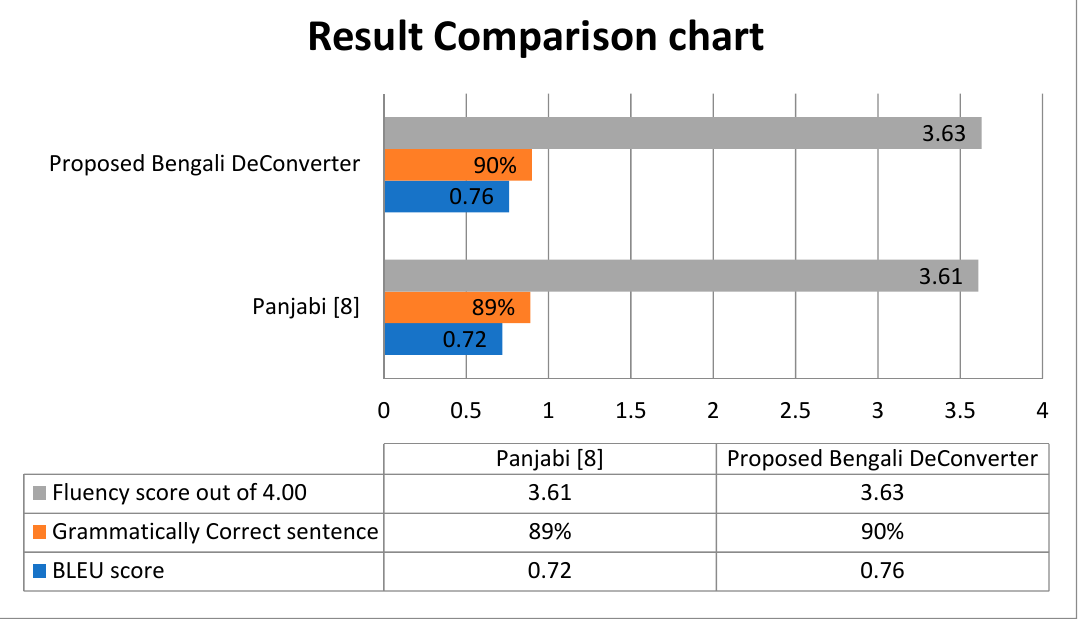
Figure 10. Result comparison with Punjabi DeConverter [8].